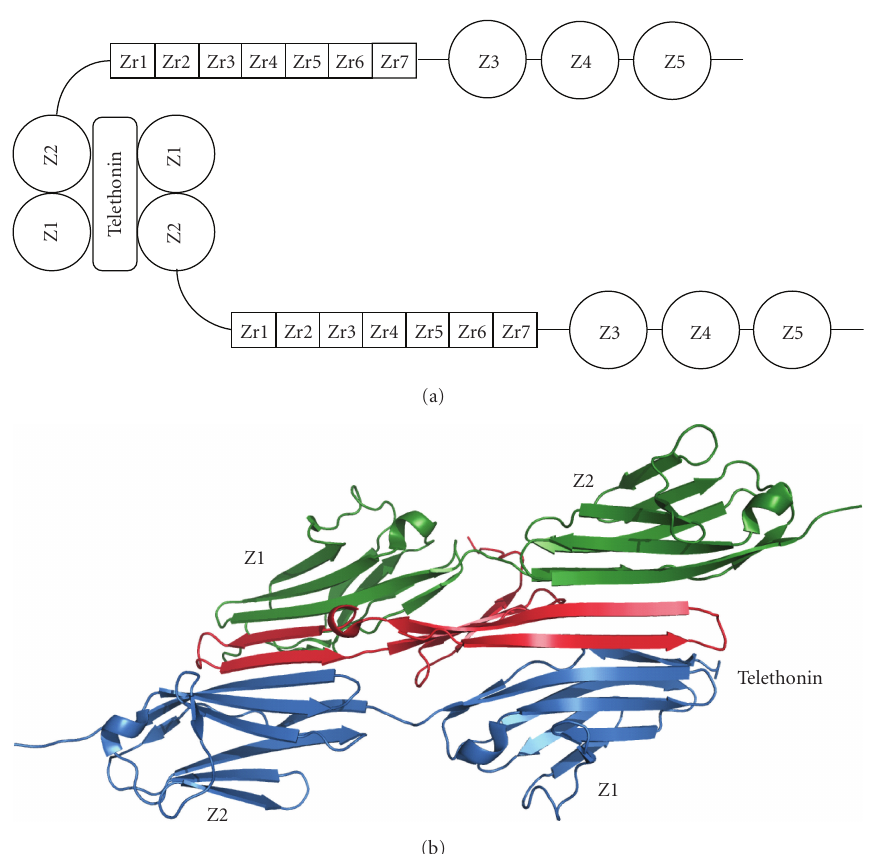
Figure 1: (a) Schematic diagram of the structure of the Z-disk region of titin. (b) Structural model of the Z1Z2-telethonin